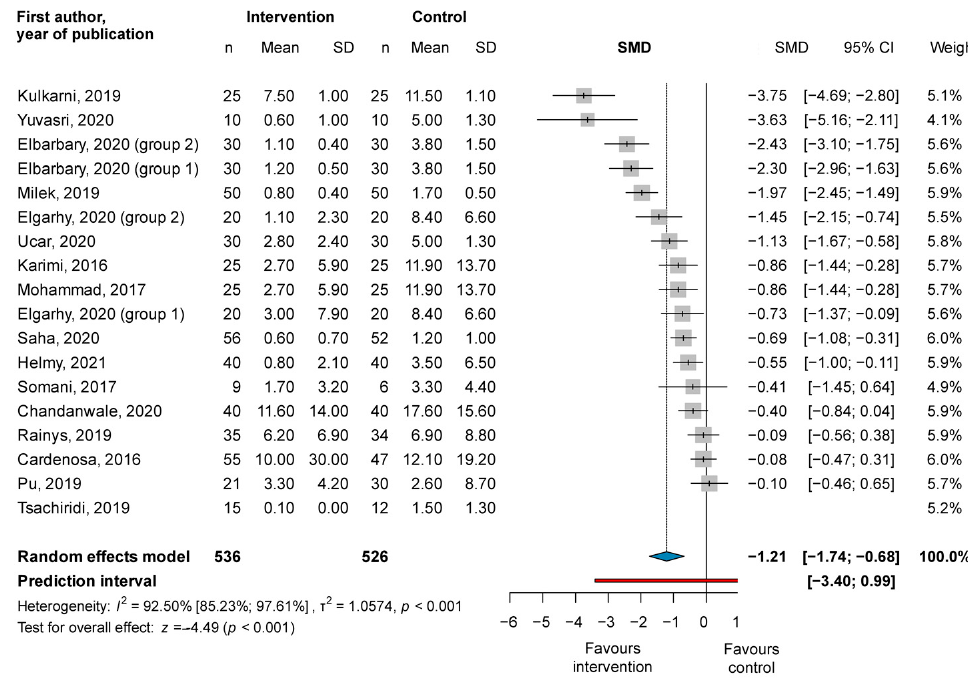
Figure 3. Forest plot for the change of wound size: platelet-rich plasma compared to conventional ulcer therapy [31,32,35,36,43,45,47,49,50,55,57,60,65,66,68,70]. Subgrouping based on ulcer etiology, the application method, and follow-up length